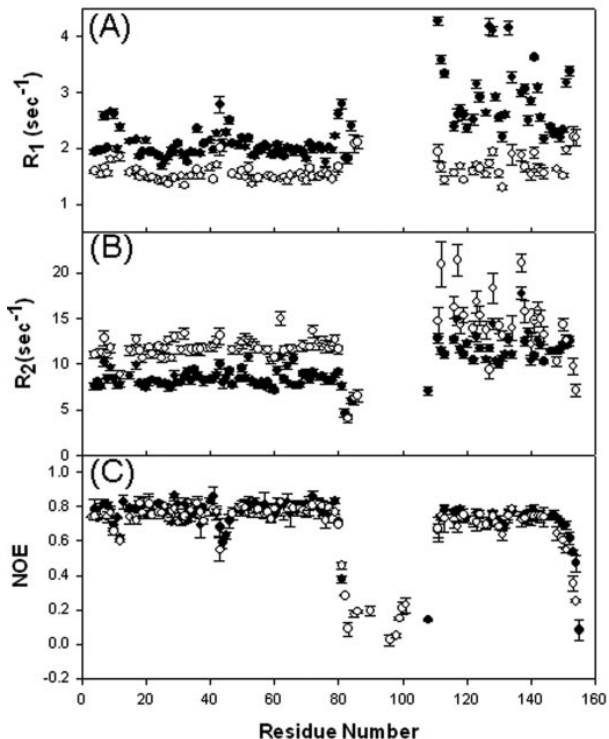
Figure 11. Sequence-dependent variations of the amide 15 N-R1 ( A ), 15 N-R2 ( B ), and 1 H- 15 N NOE (C) of LD ( filled circles ), PSBD ( filled circles ), and di-domain ( open circles ) of human BCKDHc